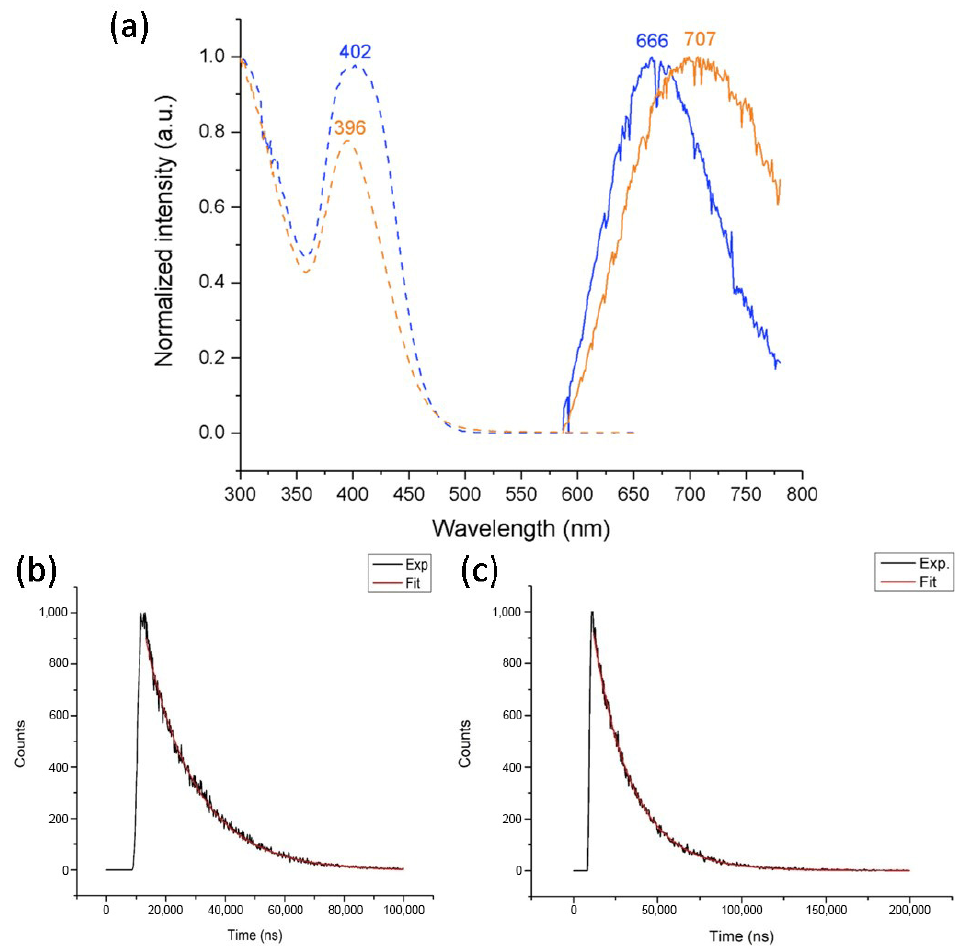
Figure 4. ( a ) The absorption spectrum of 2 (blue dashed line) and 3 (orange dashed line). The emis- sion spectrum of 2 (blue solid line) and 3 (orange solid line) dissolved in 2-MeTHF at 77K. ( b ) The photoluminescence decay curves of 2 ( λ ex = 401 nm) and ( c ) 3 ( λ ex = 396 nm) in 2-MeTHF glass rec- orded at 77 K.